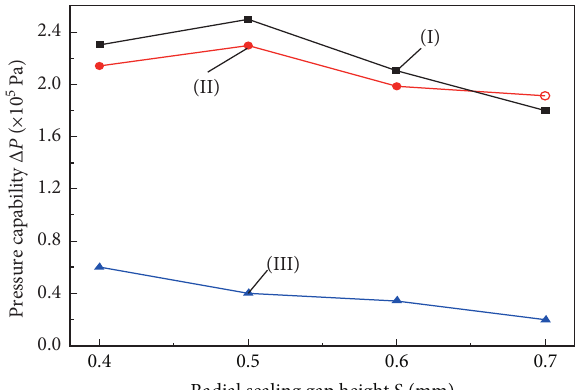
Figure 14: Influence of radial clearance on pressure resistance ability of magnetic fluid seal. (I) Experimental value of divergent magnetic fluid seal. (II) Theoretical value of divergent magnetic fluid seal. (III) Experimental value of ordinary magnetic fluid seal.